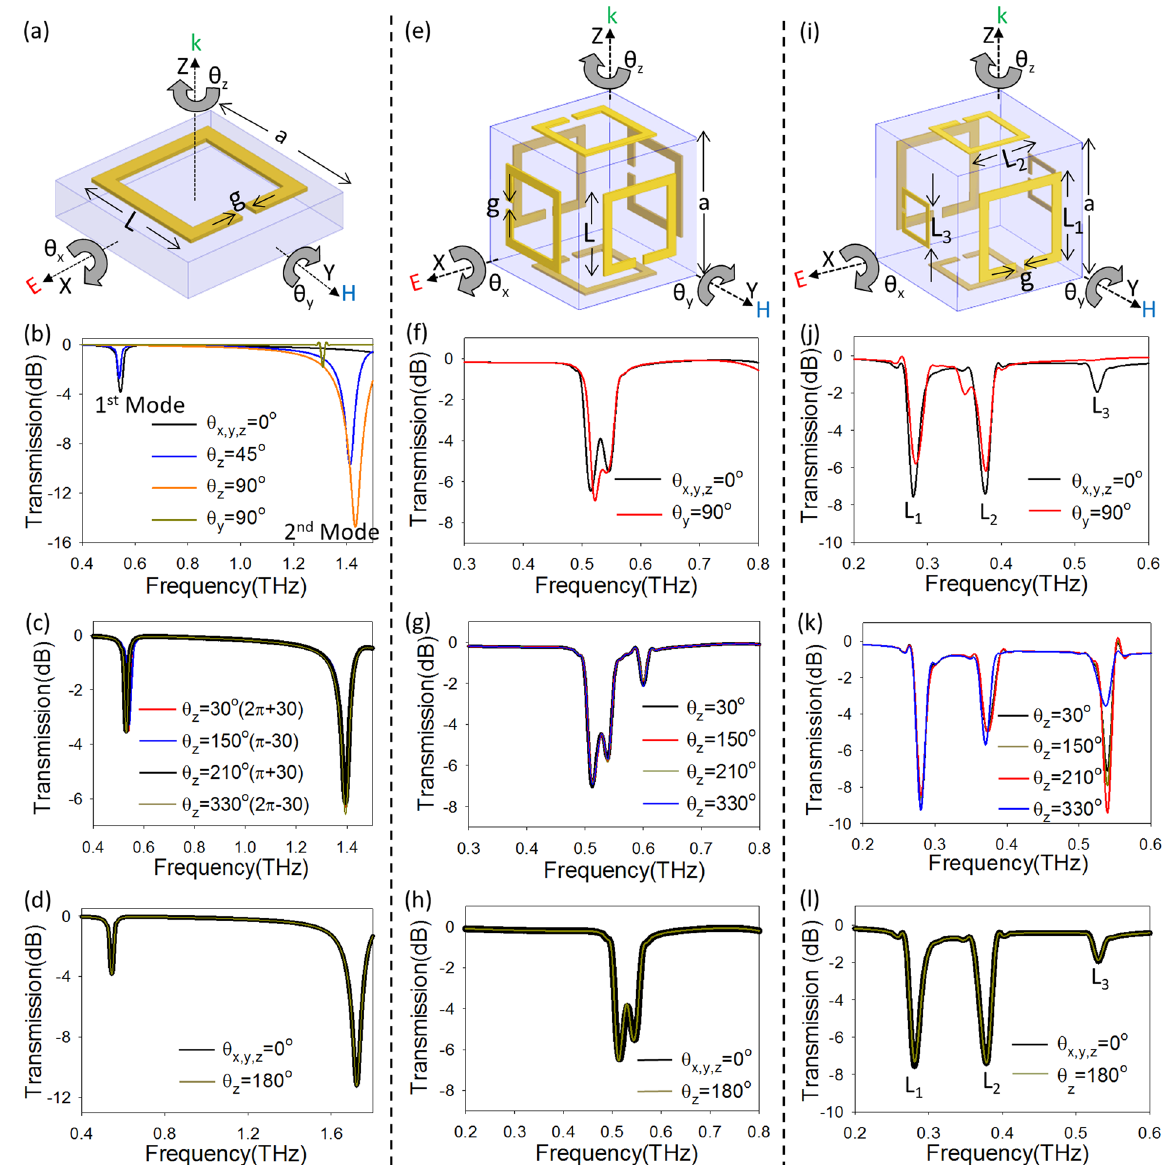
Figure 1. Illustration of two- and three-dimensional split-ring resonators (SRRs) and their simulated transmission response. ( a ) A conventional, two-dimensional SRR with L = 36 µ m, g = 4 µ m, and a = 48 µ m, that can be rotated along the X-, Y-, and Z-axis at angles θ x , θ y , θ z degrees, respectively. At the initial position the resonator has the wave at normal incidence, magnetic field (H) polarized perpendicular to the gap and electric field (E) polarized parallel to the gap. ( b ) Showing the weak transmission observed when rotated about Y-axis ( θ y ) as opposed to the strong first mode ( θ = 0°) and second mode ( θ z = 90°) ( c ) Overlap of the resonance at 0.52 THz for rotations of 30°, 150°, 210°, and 330° about the Z-axis. ( d ) Transmission for the initial position ( θ = 0°) and ( θ z = 180°), proving the isotropy of the transmission for any angle θ and n π ± θ (n = 1, 2). ( e ) A cubic three-dimensional split ring resonator with L = 36 µ m, g = 4 µ m, and a = 110 µ m, capable of maintaining a high SNR when rotated along all three-axes. ( f – h ) Simulated transmission response of the cube showing, ( f ) the high but ambiguous transmission response when rotated about Y-axis, ( g ) an isotropic transmission response for any angle θ and n π ± θ (n = 1, 2) similar to the 2-D resonator, and ( h ) perfect overlap of the transmission at 0° and 180°. ( i ) A cubic rotation sensor with varying resonator length along each axis with L 1 = 72 µ m, L 2 = 54 µ m and L 3 = 36 µ m while ‘g’ and ‘a’ are kept constant as before. ( j – l ) Simulated transmission response of the cube showing, ( j ) the ability of the cube to maintain the high transmission for Y-axis rotation, ( k ) significant changes in transmission between rotations of angle θ , and n π ± θ (n = 1, 2), and ( l ) special case of a 180° rotation that perfectly overlaps the θ = 0° initial